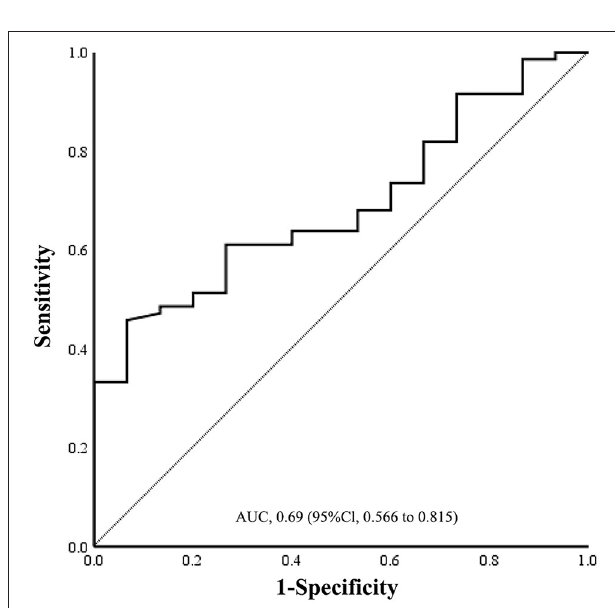
FIGURE 6 | Sensitivity and specificity of ROC curve in the assessment of prediction of AT by MVD 0.5 − 1.0DD . Cutoff value was 82.23 µ m. Sensitivity was 61.1%, and specificity was 73.3%. ROC, receiver operating characteristic; AUC, area under curve; AT, atherothrombosis; MVD, mean venular